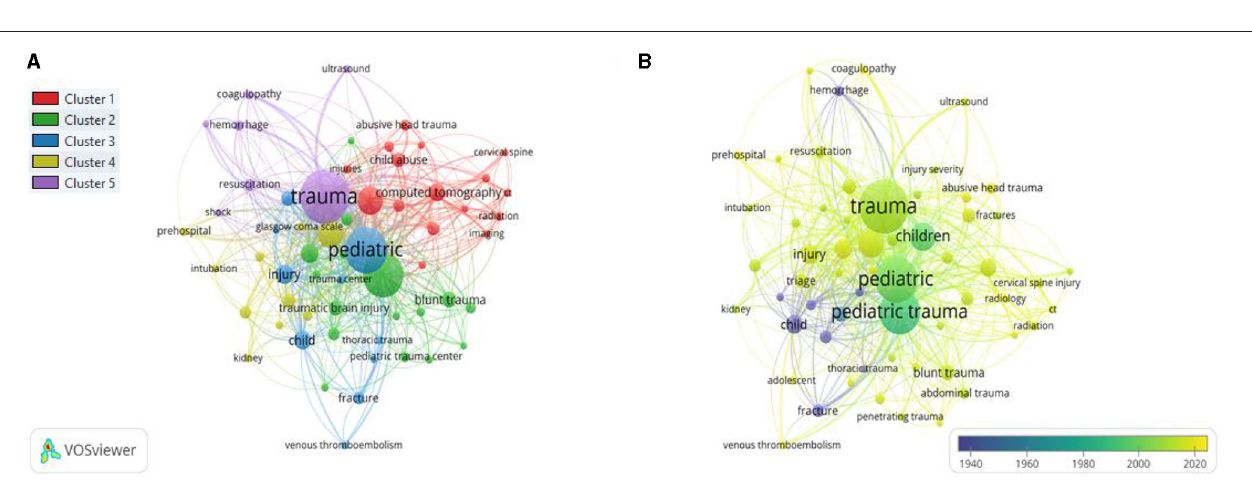
FIGURE 10 | (A) Author keywords network visualization. (B) Overlay visualization by time (year).